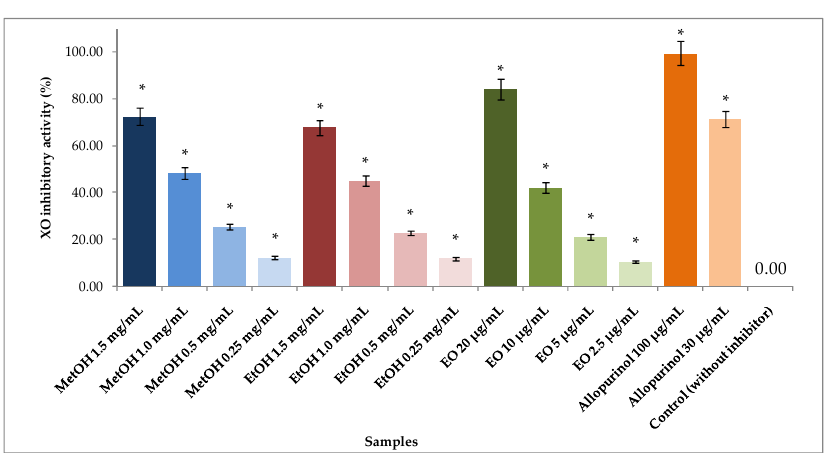
Figure 8. Xanthine oxidase (XO) inhibitory activity of allopurinol, extracts, and EO from A. foeniculum AdB evaluated at varying concentrations. Results are mean ± SD of three replicates per condition. * Significantly different (Dunnett t -tests, 2-sided) from the control (without inhibitor) conditions ( p < 0.001).